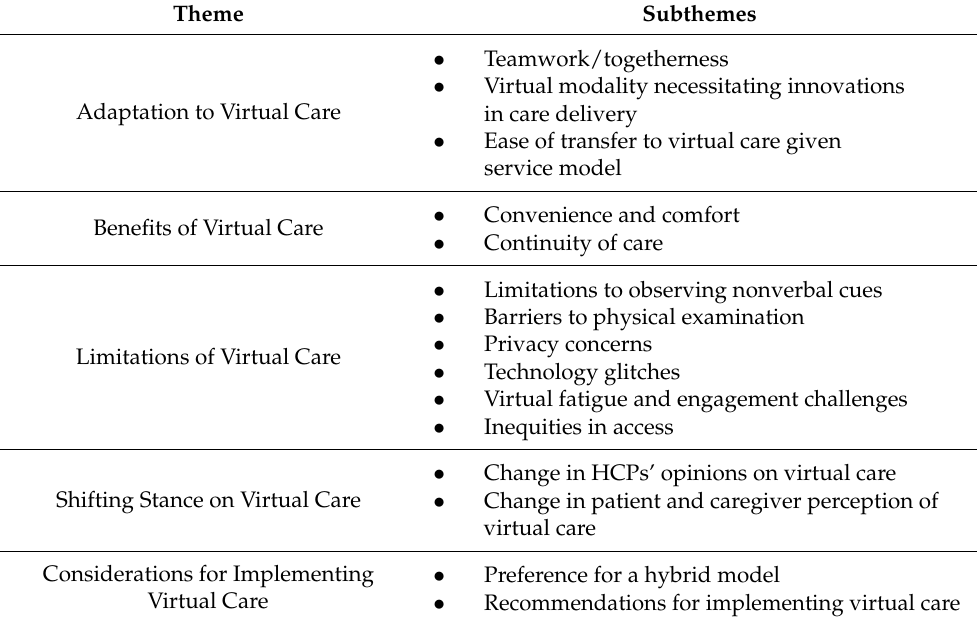
Table 1. Themes and subthemes generated from the semistructured